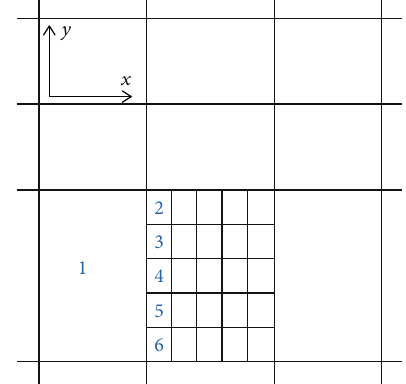
Figure 7: Grid re fi nement in Cartesian